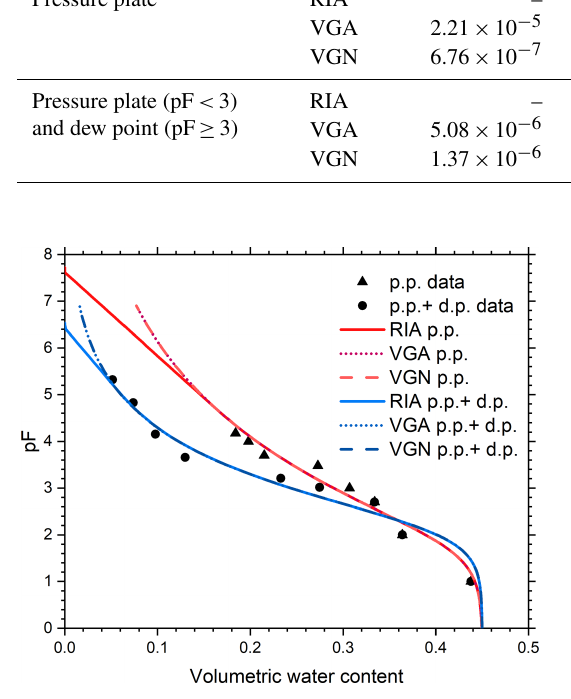
Figure 3. Soil water retention data obtained by Bittelli and Flury (2009) from samples placed on pressure plates (i.e. p.p. data) or from a combination of pressure plates for the wettest three data points and dew point measurements for the driest six data points (i.e. p.p. and d.p. data). The curves show the fits of the soil water retention curves according to van Genuchten (1980; VGN), Ippisch et al. (2006; VGA), and Eq. (5)